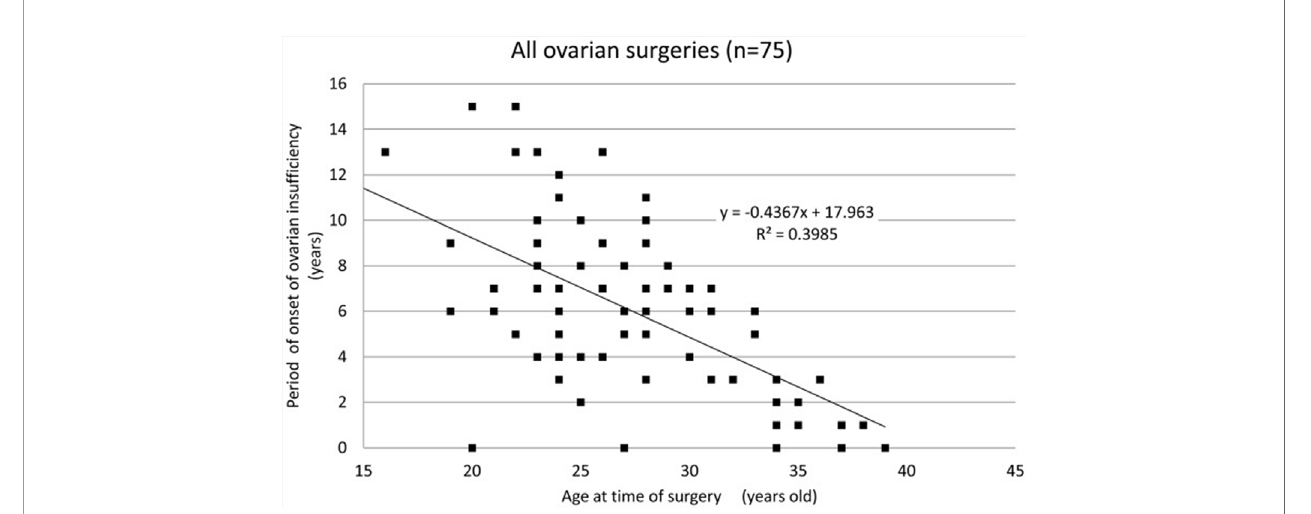
FIGURE 1 | Period of onset of ovarian insuf fi ciency post-ovarian surgery for each patient by age. A strong correlation is observed between age at the time of surgery and the period of onset of ovarian insuf fi ciency (correlation coef fi cient: − 0.63, Spearman ’ s rank correlation coef fi cient)